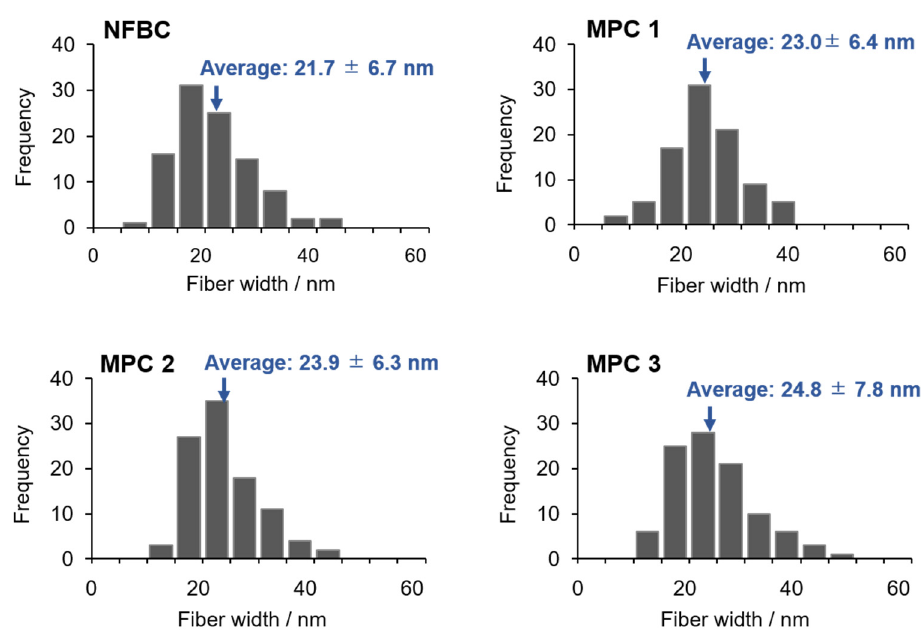
Figure 5. SEM images of NFBC and MPC 1 ‒ 3.